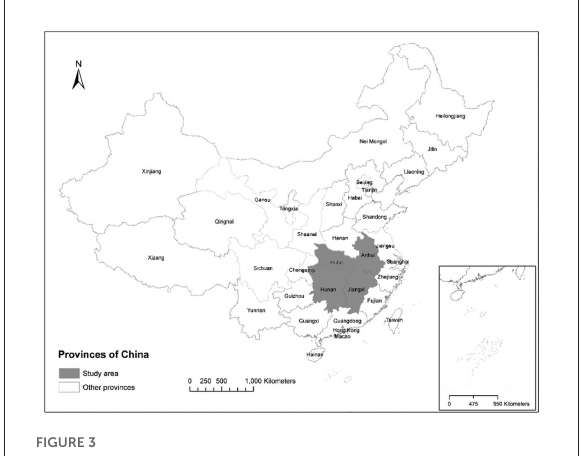
FIGURE3 Location of surveyed Provinces. Source: